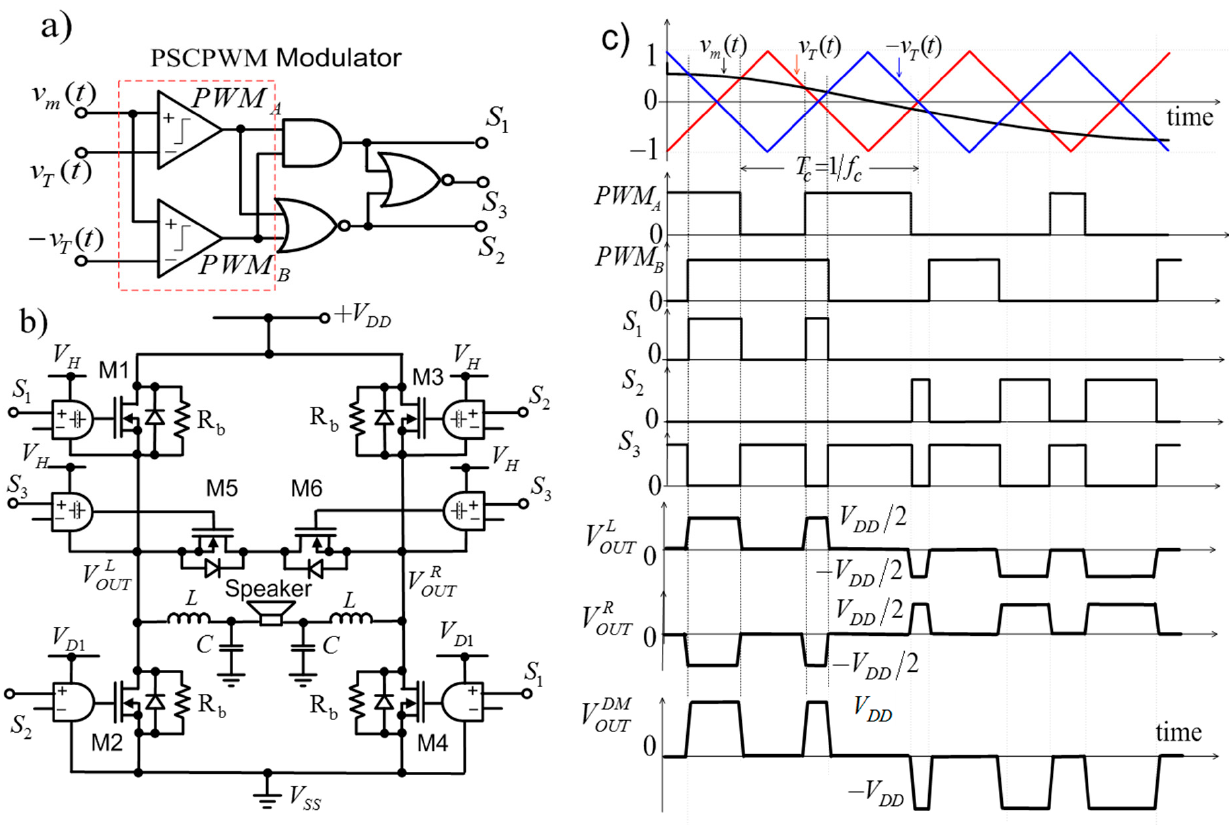
Figure 2. Class-BD amplifier based on PSC PWM modulation scheme: ( a ) Block diagram of PSC PWM modulator; ( b ) the output stage; ( c ) time domain waveforms at the outputs of the modulator and amplifier.